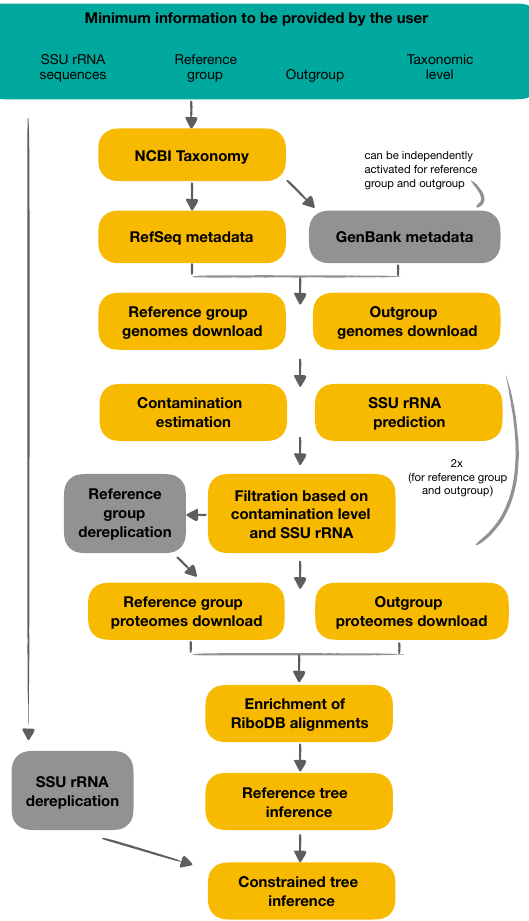
Figure 1. Overview of ORPER workflow. Users should specify at least four pieces of information to run ORPER: (i) their SSU (16S) rRNA sequences, (ii) the taxon of interest, (iii) the outgroup of the phylogeny and (iv) the taxonomic level (Green part). Yellow boxes are mandatory steps of ORPER whereas grey boxes are optional steps. Contamination estimation, SSU rRNA prediction and filtration are performed twice, once for the reference group and once for the